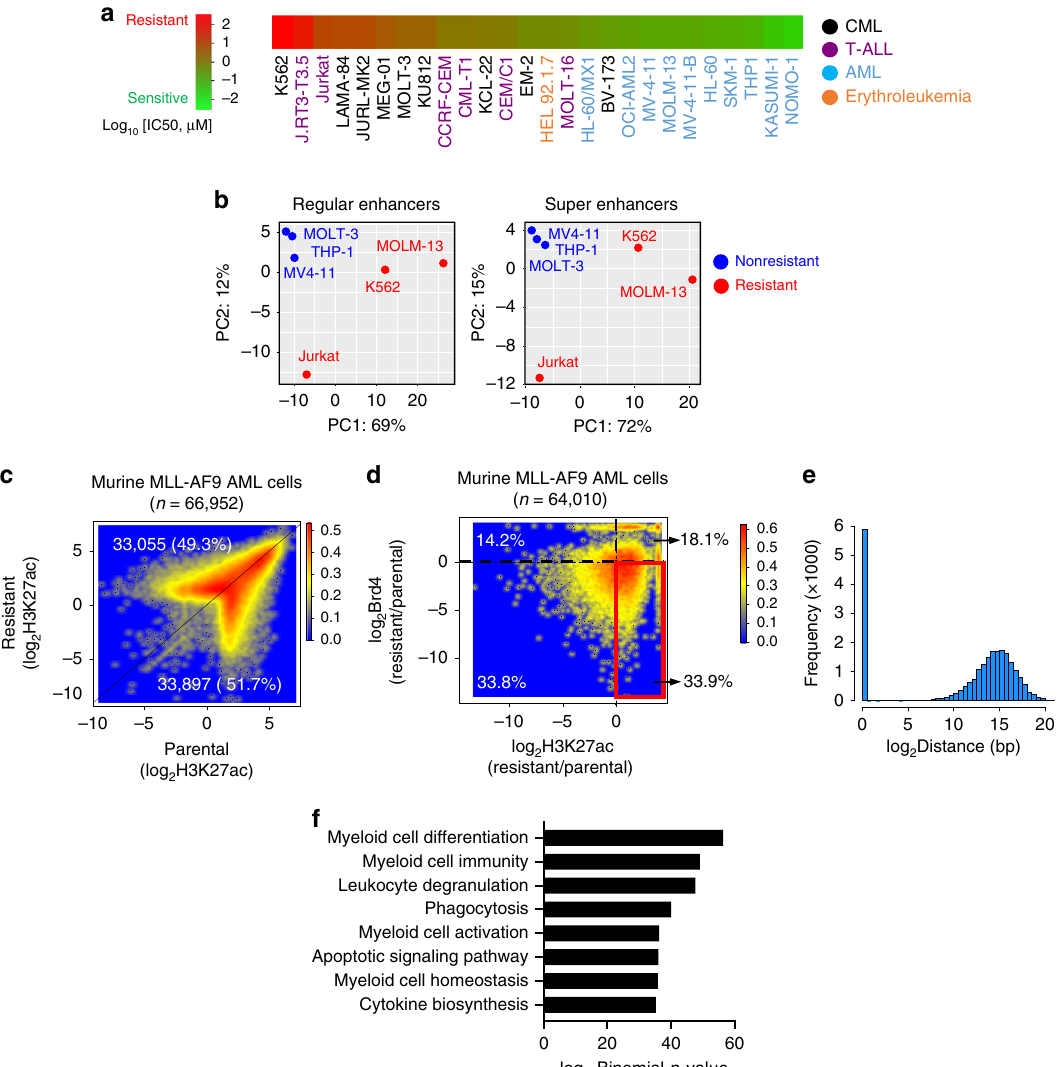
Fig. 1 BETi-resistant leukemia cells undergo BRD4-independent enhancer remodeling. a Heatmap representing the IC 50 values of the indicated leukemia cell lines to a BRD4 inhibitor JQ1. The IC 50 values were obtained from the published database PHARMACODB. b The principal component analysis (PCA) of enhancer region distributions in the indicated BETi-sensitive and BETi-resistant leukemia cells. c Smoothed scatter plot representation of H3K27ac- enriched regions in paired BETi-sensitive (parental, x -axis) and BETi-resistant ( y -axis) murine AF9 AML cells. Color code represents the dot density. d Smoothed scatter plot representation of differential H3K27ac-enriched regions and Brd4 enriched regions in paired BETi-sensitive (parental) and BETi- resistant murine AF9 AML cells. Red highlighted region: genomic regions displayed increased H3K27ac enrichment with no change or decreased Brd4 binding in BETi-resistant murine AF9 AML cells. All the publicly available H3K27ac and BRD4 ChIP-seq datasets used in Fig. 1b – d were summarized in Supplementary Table 1. Color code represents the dot density. e The histogram showing the distribution of distance between the genomic regions highlighted within the red box in Fig. 1d and their closest genes. f Genomic Regions Enrichment of Annotations Tool (GREAT) analysis of genomic regions highlighted in the red box of Fig.